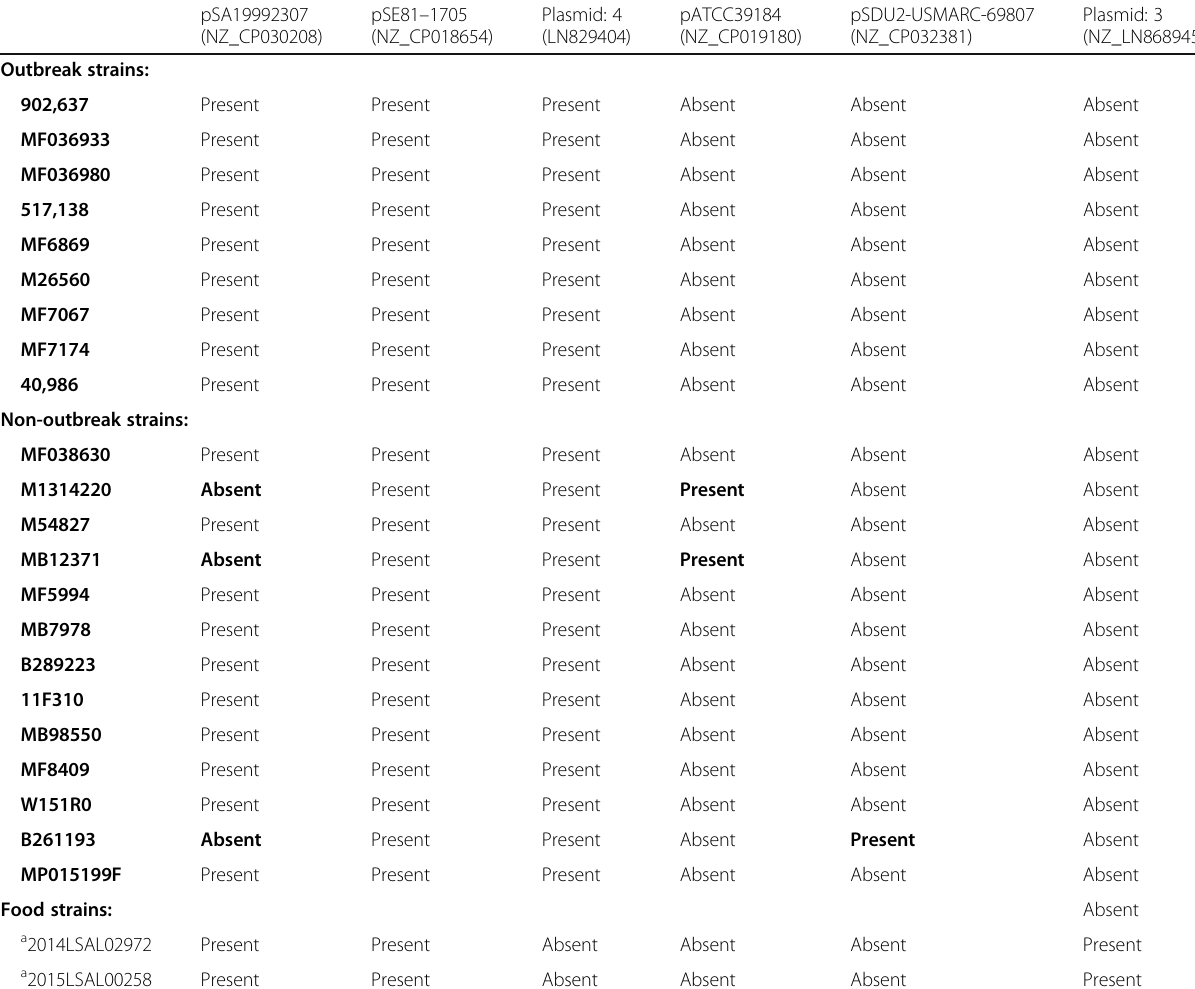
Table 5 Distribution of plasmids among outbreak and non-outbreak strains of Salmonella